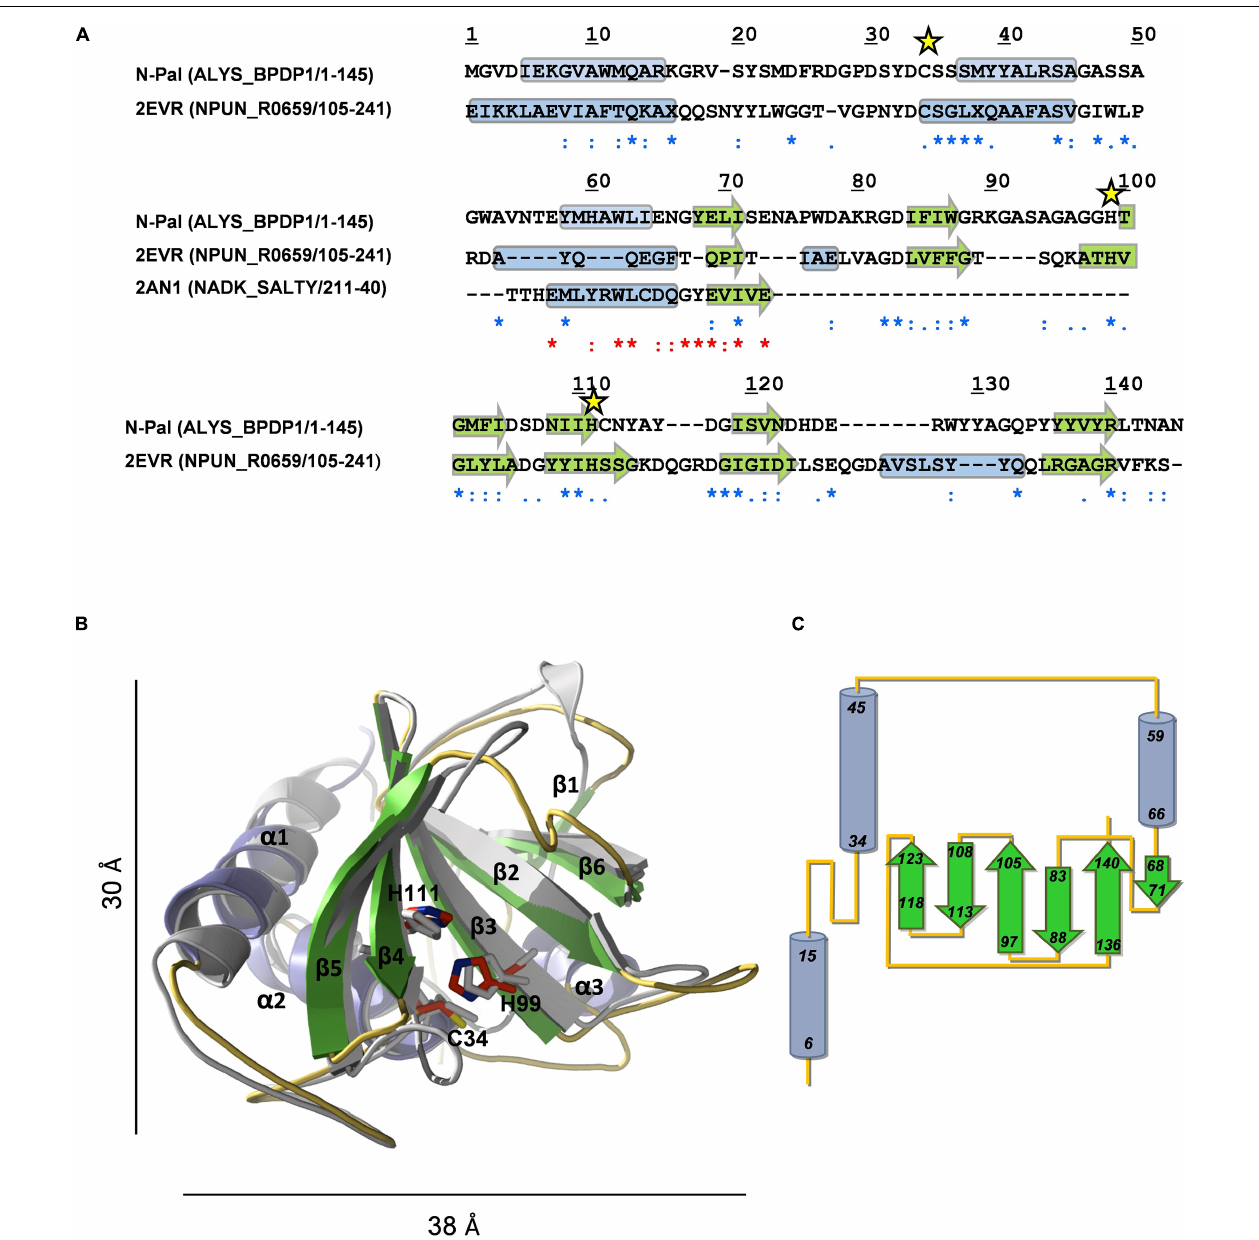
FIGURE 3 | Structural model of N-Pal. (A) Sequence alignment of the target and the templates (PDB entries: 2EVR and 2AN1) used to build N-Pal 3D model with MODELLER. UniProtKB accession numbers and regions comprised in the alignment are shown in parenthesis. Asterisks, colons, and dots stand for strictly conserved residues, conservative, and semiconservative substitutions, respectively, with relation to 2EVR (blue) or 2AN1 (red) sequences. Yellow stars indicate the catalytic residues. Secondary structural elements of template structures, and sequence-based predicted for N-Pal are indicated by cylinders (helices) and arrows ( β -strands). (B) Structural superimposition of the N-Pal model generated with MODELLER (cartoon representation; helices in light blue, arrows in green, and loops in orange) and the 2EVR template (gray). Catalytic residues, in stick representation, are colored in gray (template) or by element (N-Skl; C: red, N: blue; S: yellow). For the sake of clarity, the helix of 2EVR previous to β 6 is not shown. (C) Topology diagram of N-Pal